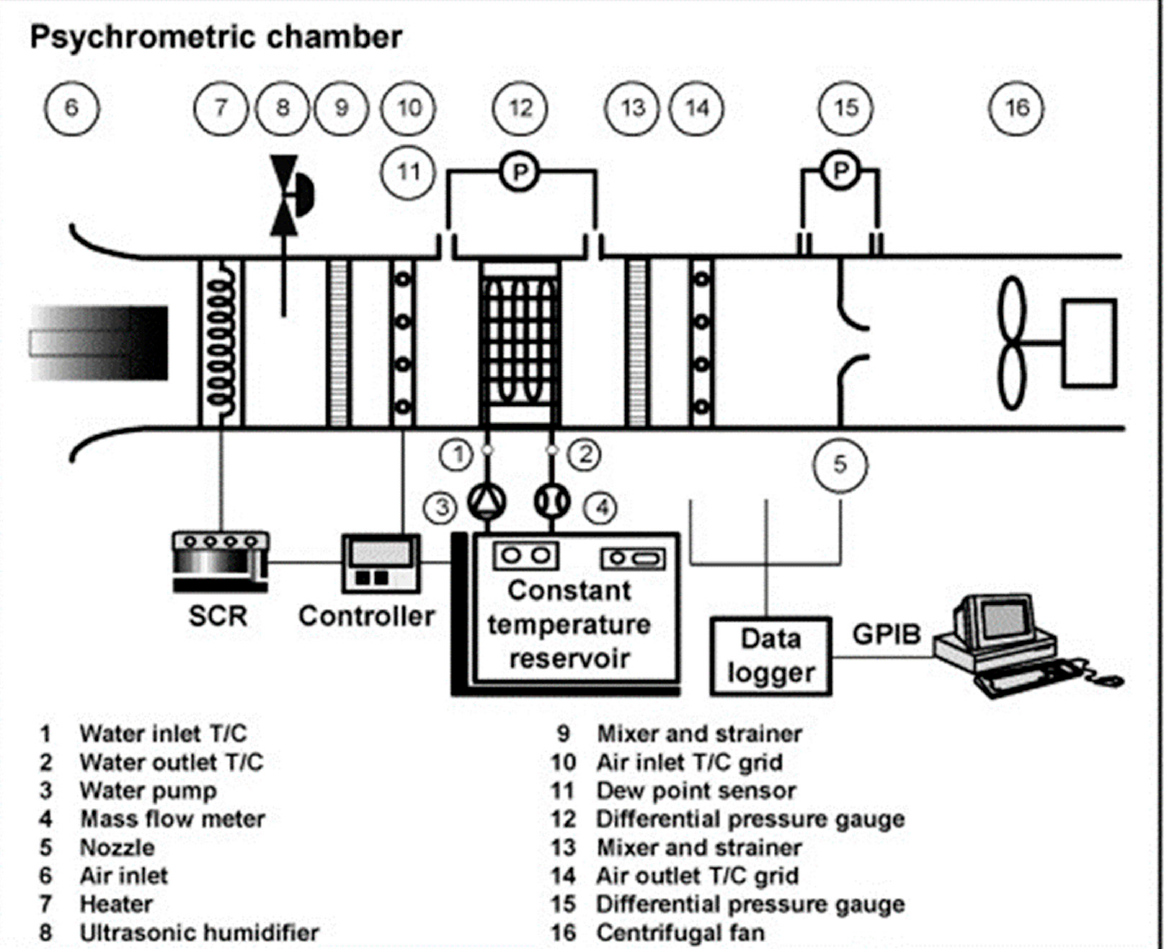
Figure 5. Schematic representation of a typical experimental setup [18].